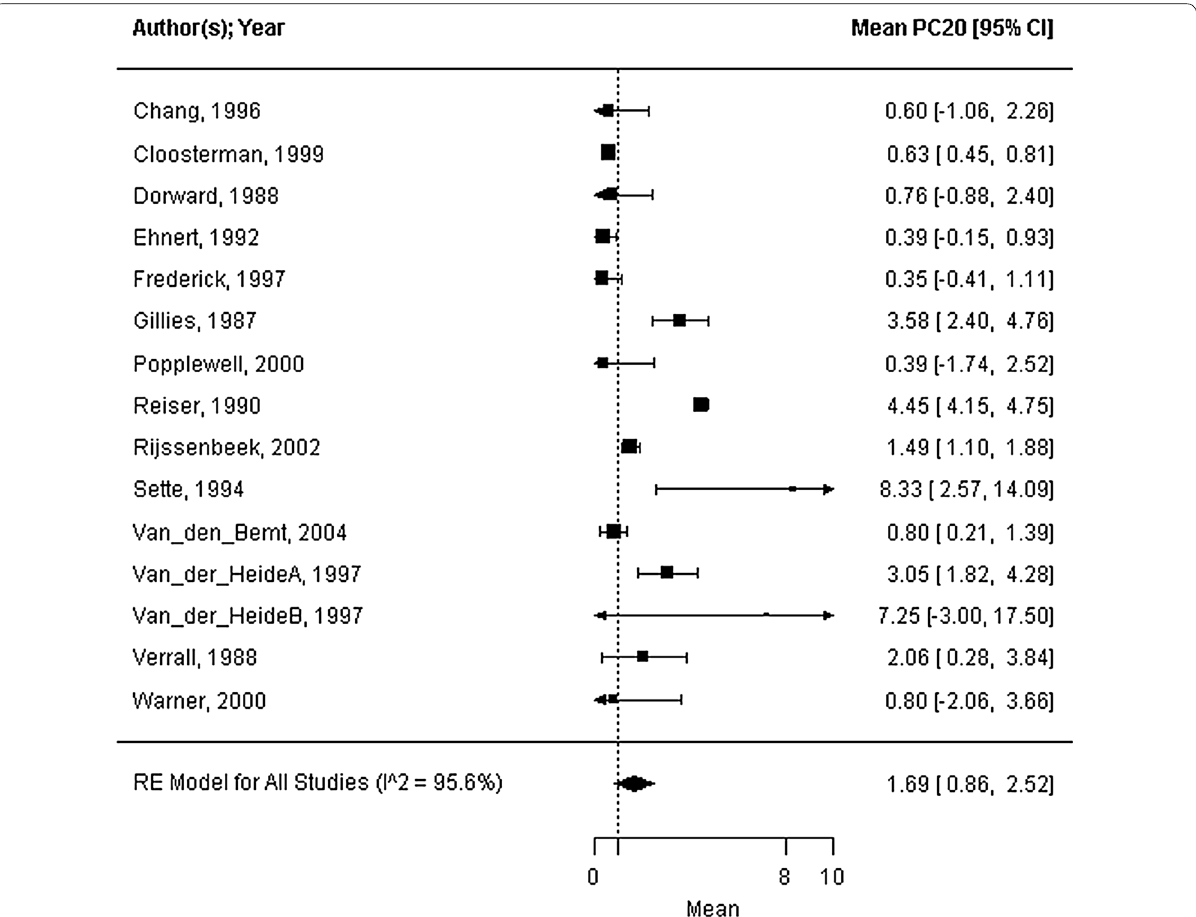
Fig. 5 Forest plot of the PC 20 at